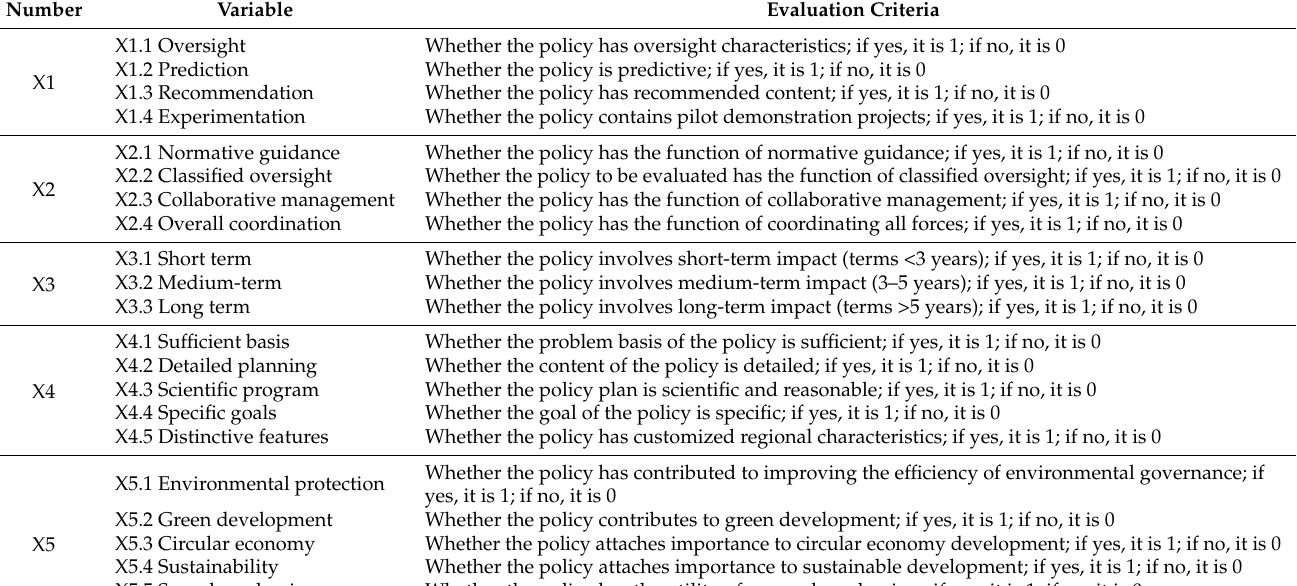
Table 3. Evaluation criteria of second-level